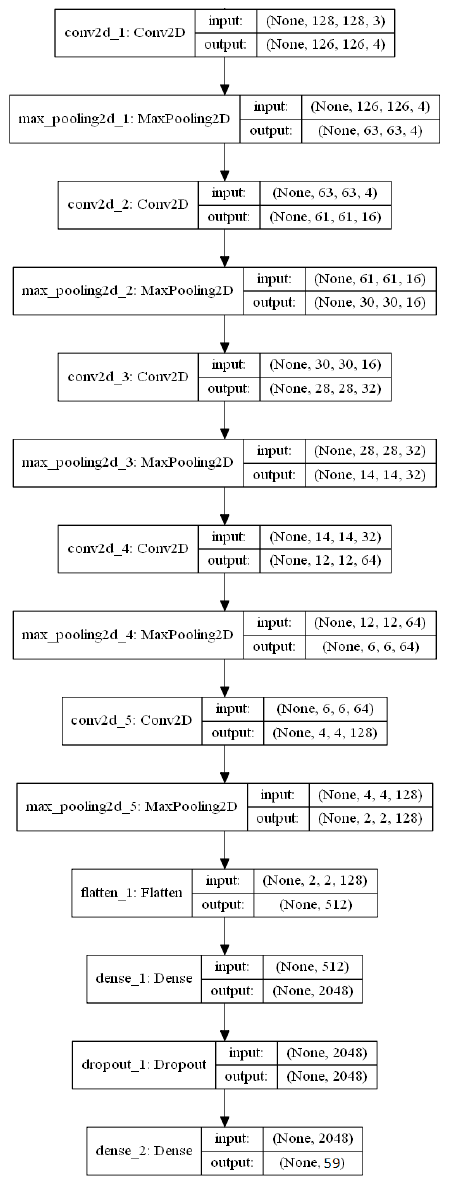
Figure 2. Layered structure of 14-DCNN model.